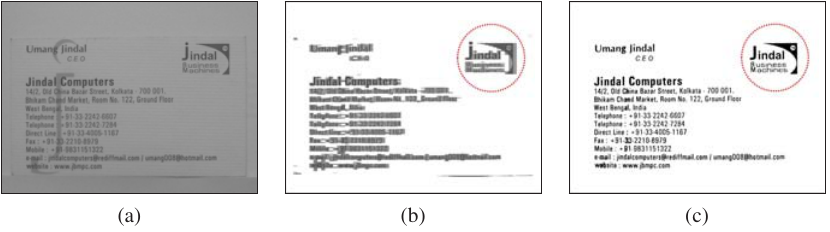
Figure 11. Sample business card image with partial misclassification. (a) An input image with a logo that consists of text and image that are close to each other at some points. (b) Text and image together has formed a single CC encircled. (c) Image in the encircled area could not be